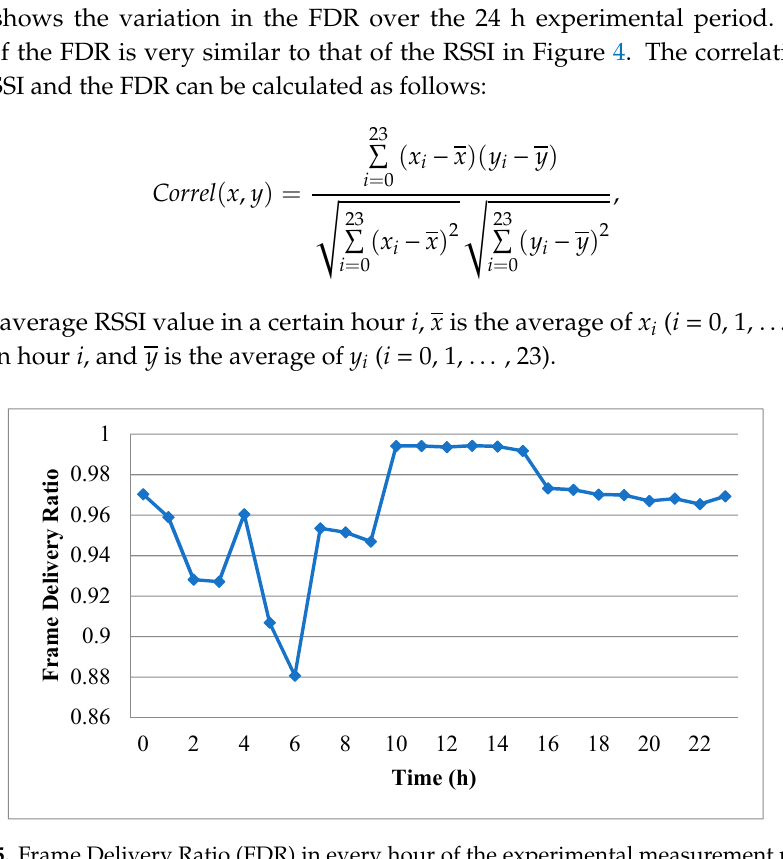
Figure 4. Average Received Signal Strength Indicator (RSSI) value in each hour of the experimental measurement period.